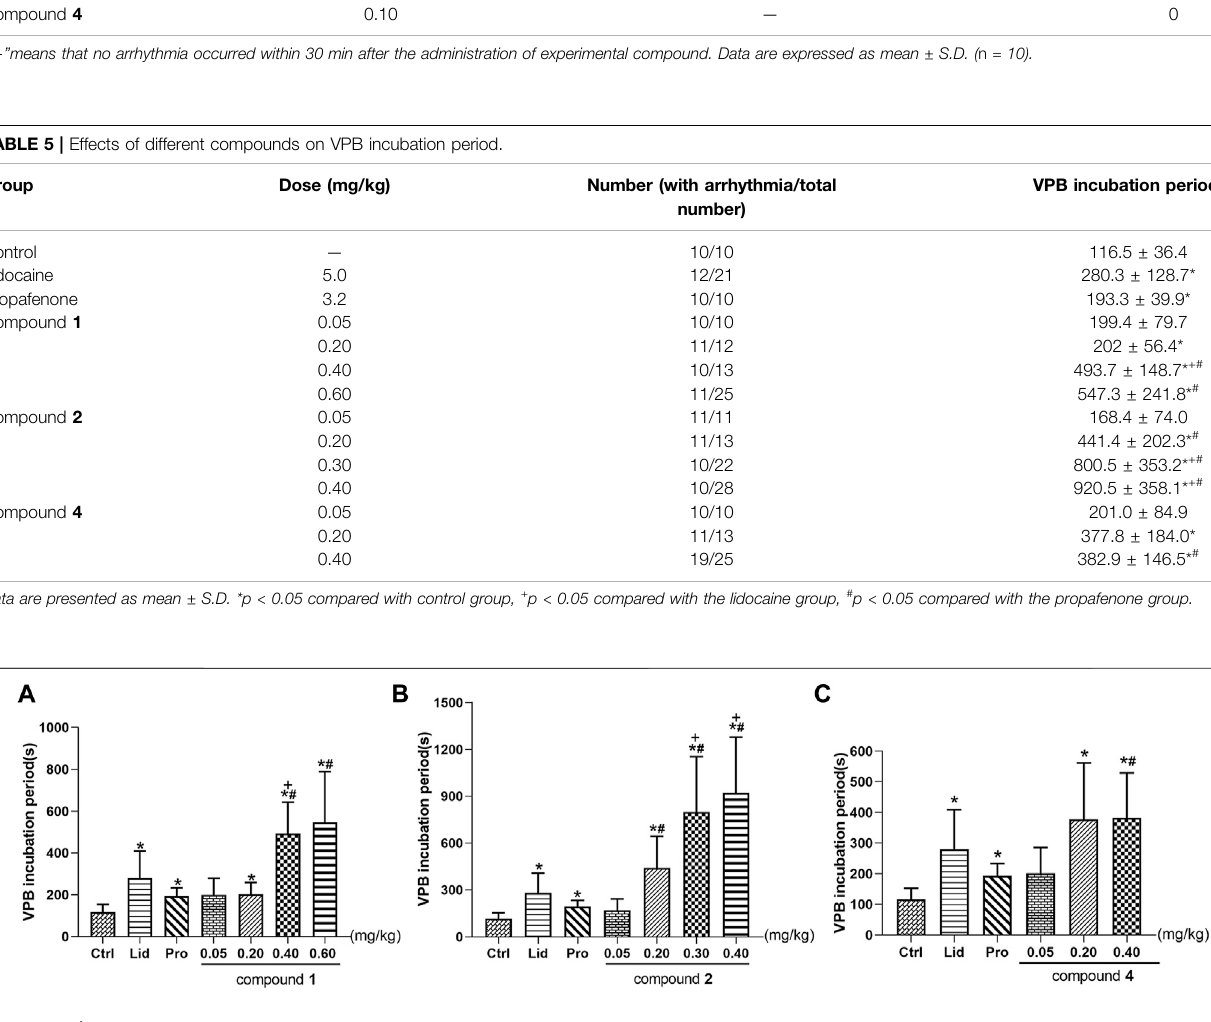
FIGURE5| Effects of different experimental compounds on VPB incubation period (A) : compound 1 ; (B) : compound 2 ; (C) : compound 3 . Data are presented as mean ± SD. * p < 0.05 compared with control group, + p < 0.05 compared with the lidocaine group, # p < 0.05 compared with the propafenone group. Ctrl, the control group. Lid, lidocaine; Pro,